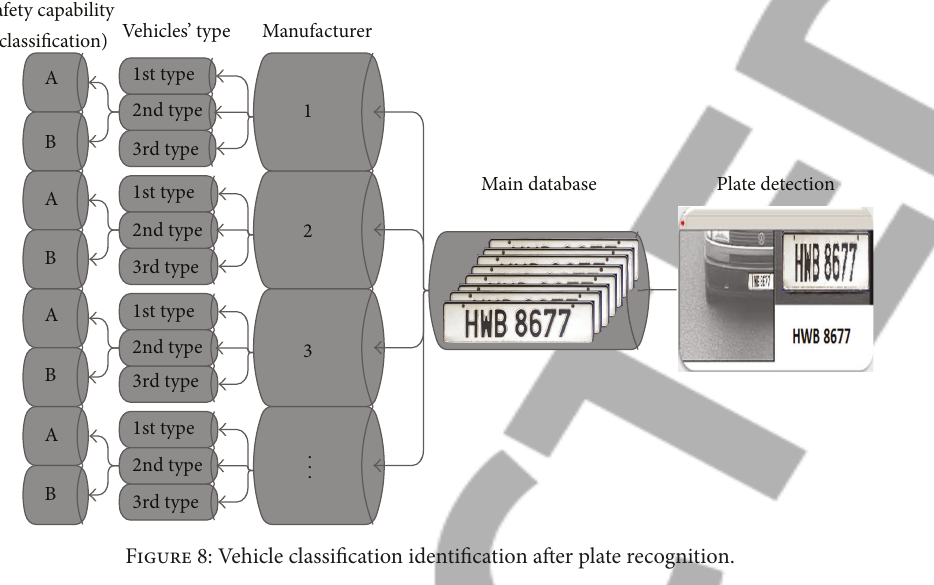
Figure 8: Vehicle classification identification after plate recognition.